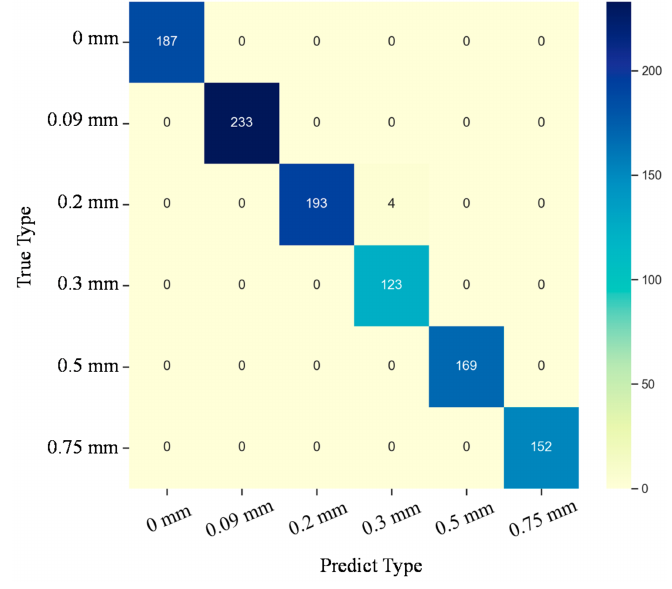
Figure 15. The confusion